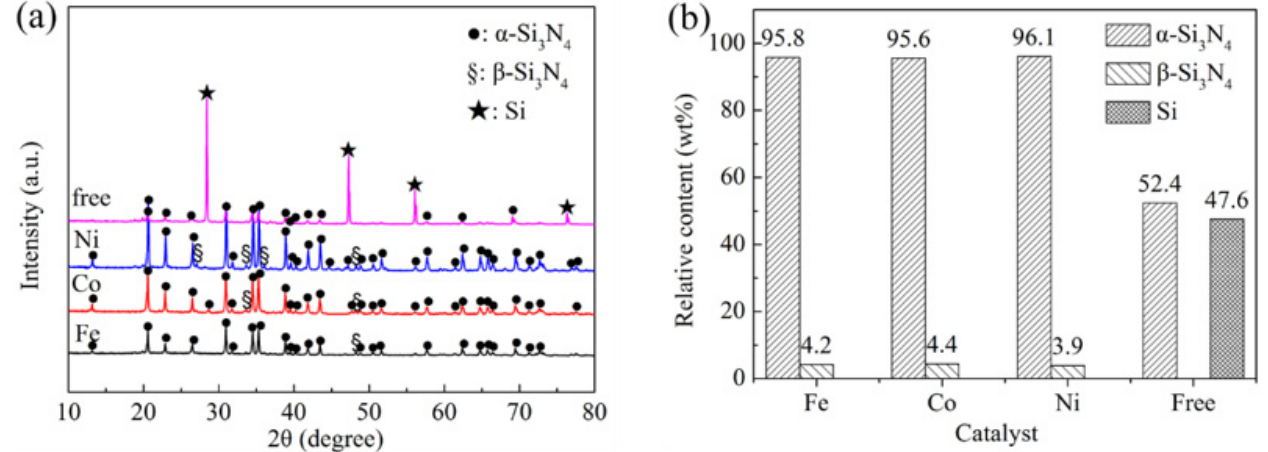
Figure 2. XRD patterns of samples and relative content of the crystalline phases in the final products obtained by 5 h of nitridation at 1250 °C using various catalysts. ( a ) XRD patterns and ( b ) relative